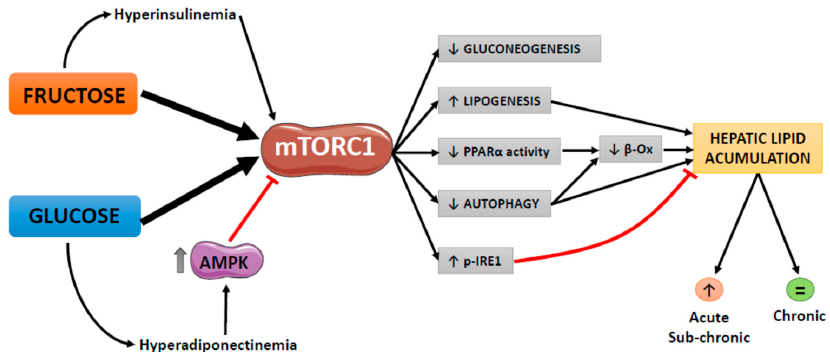
Figure 5. mTORC1 as a key hub transducing the metabolic effects of glucose and fructose in the liver. Fructose activates mTORC1 leading to reduced gluconeogenesis and enhanced lipogenesis which, together with PPAR α / β -oxidation activity and autophagy inhibition contribute to hepatic fat